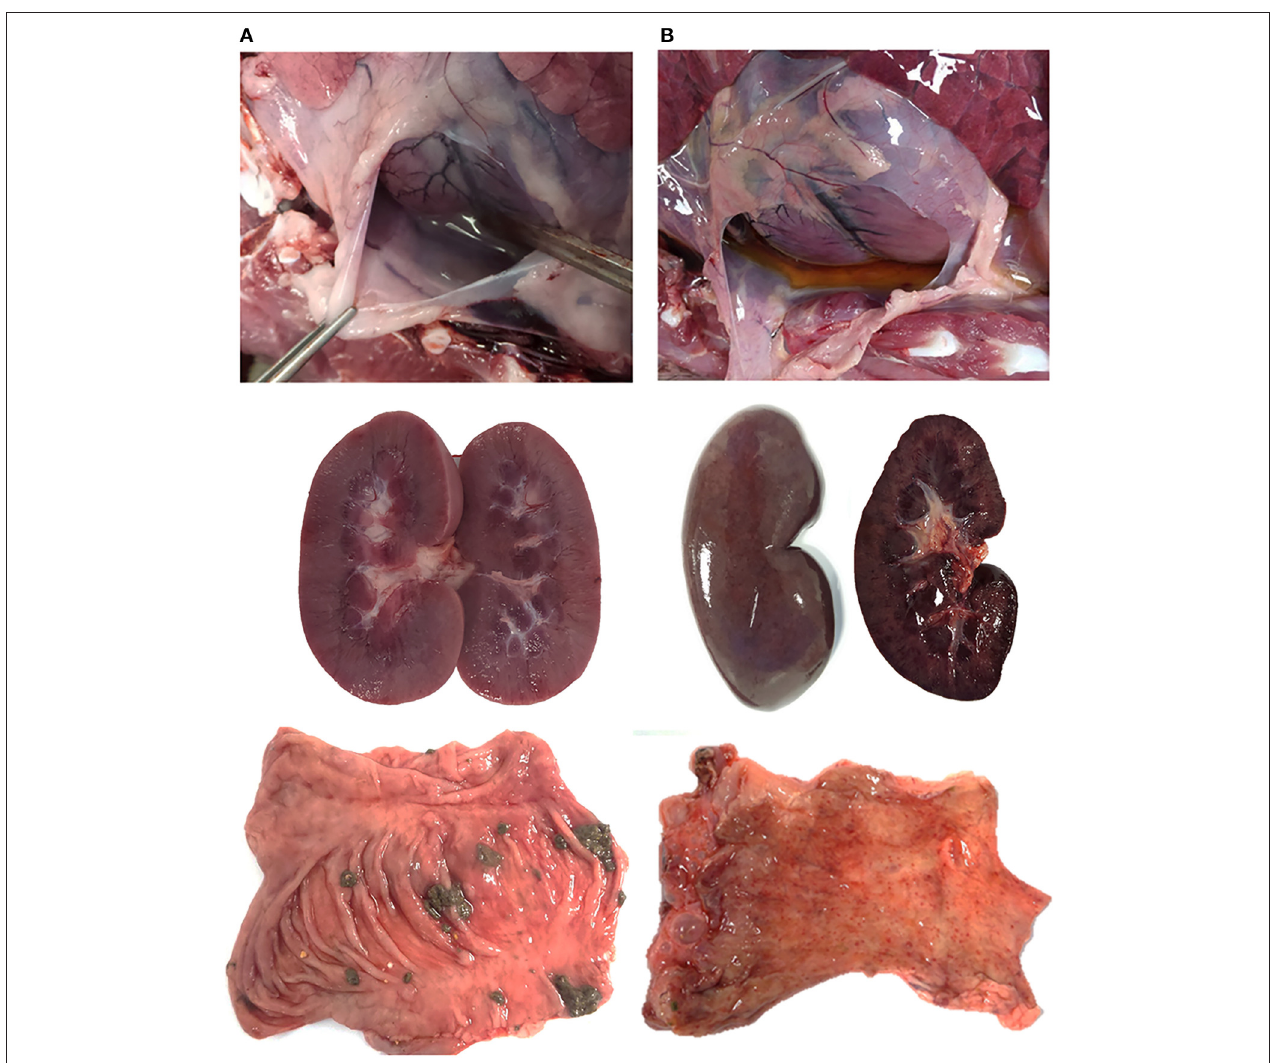
FIGURE 4 | Survey view of pericardial sac (I), kidney (II), and mucosal surface of the intestine (III) from (A) wild boar orally vaccinated with Lv17/WB/Rie1 and (B) intramuscularly challenged controls inoculated with virulent ASFV Arm07. (B) Shows hydropericardium (IB), congestive kidney with acute multifocal ranging from petechial to ecchymotic hemorrhages on the cortex surface (IIB), and numerous acute petechiae on the mucosal surface of the colon